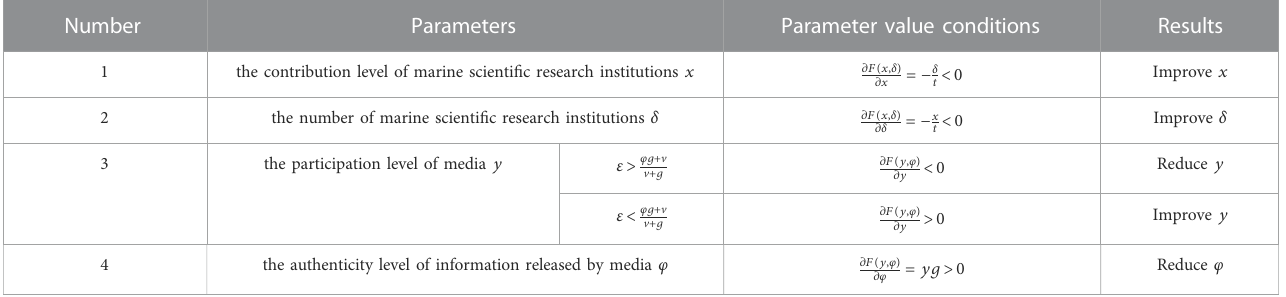
TABLE 7 Parameter value conditions in general